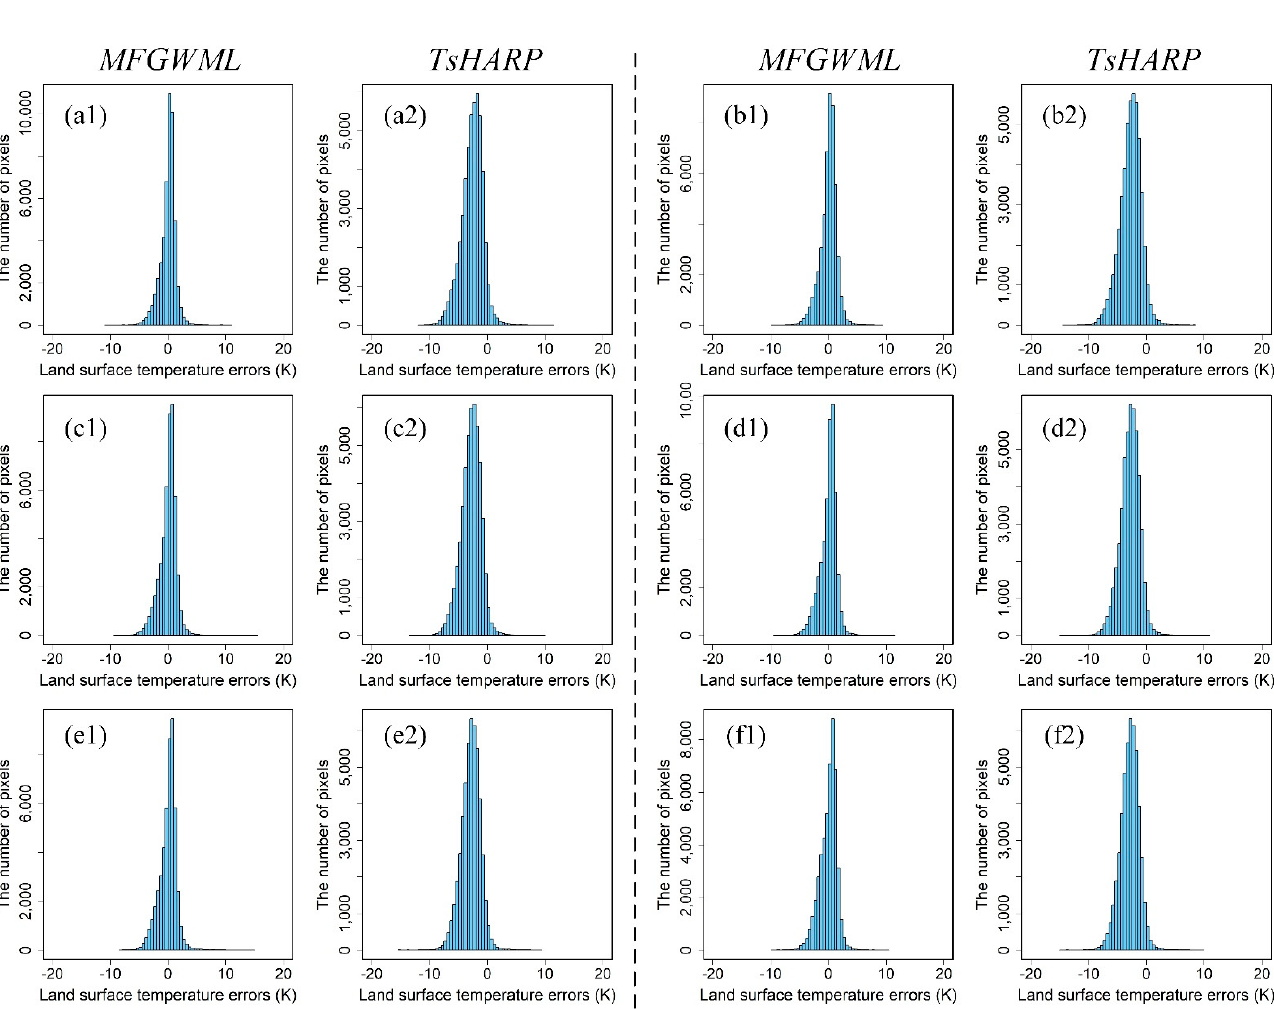
Figure 8. LST error distribution histograms of the MFGWML and TsHARP models for the six downscaling schemes: ( a1 , a2 , b1 , b2 , c1 , c2 , d1 , d2 , e1 , e2 , f1 , f2 ). Plots ( a1 , a2 ) represent the LST error distribution histograms for Scheme 1, which corresponds to the MFGWML and TsHARP models, respectively. The remainder of the plots are named in the same manner.